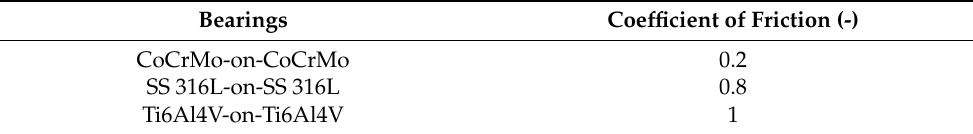
Table 3. Coefficient of friction for different materials of metal-on-metal.